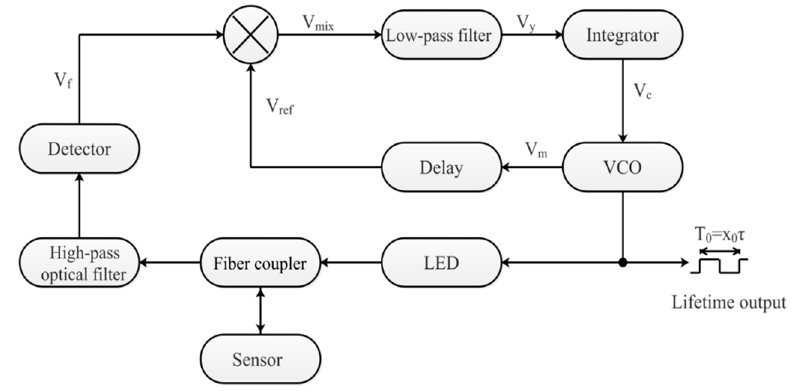
Figure 3. Sketch map of demodulation for fluorescence lifetime.